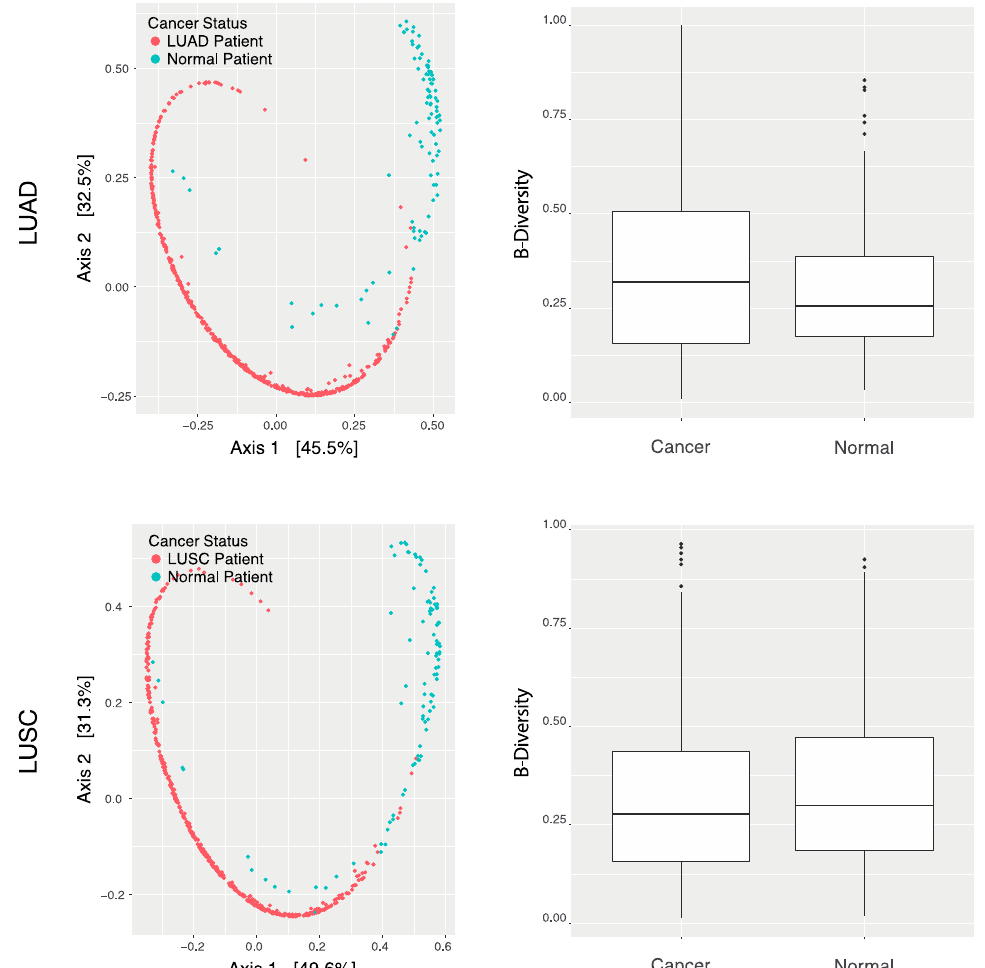
Figure 1. Wholistic lung sample microbiome analysis. Multidimensional Scaling Bray–Curtis Ordina- tion plots of LUAD and LUSC (red), and normal patient (turquoise) microbial landscapes. Bar chart of β -diversities of all mapped species by LUAD, LUSC, and normal samples.